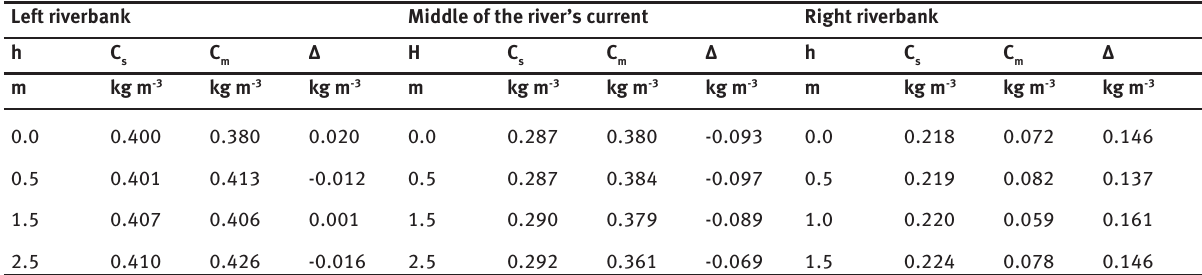
) compared with the measurements of chloride content (C s